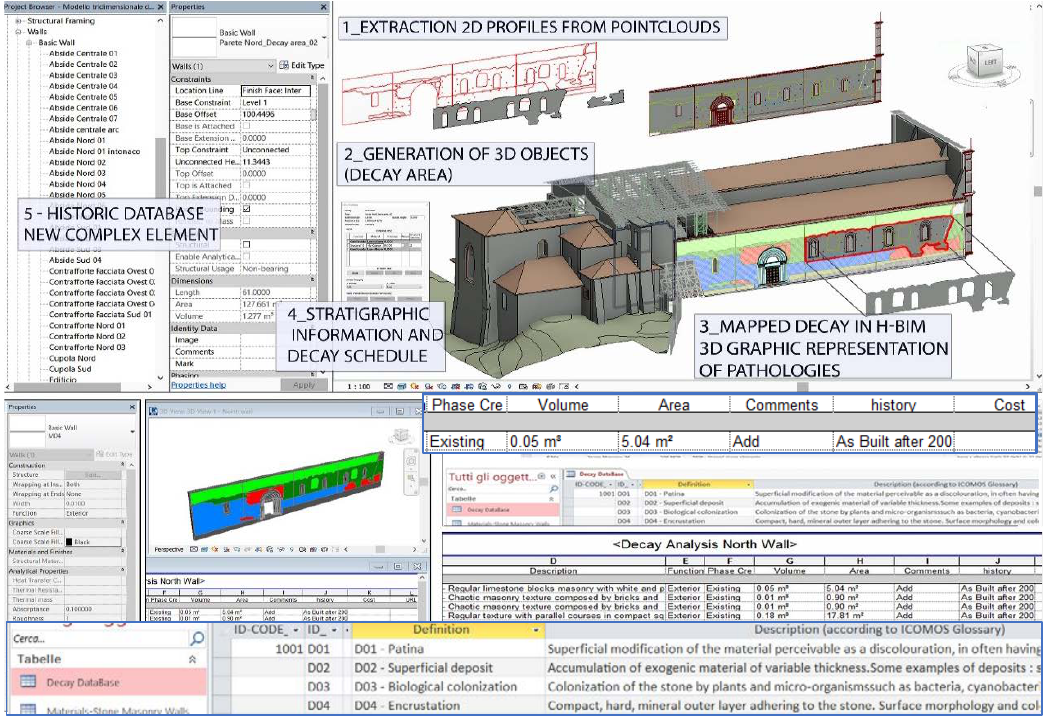
Figure 5. HBIM Material and Decay Mapping DB data management. From 2D to 3D HBIM NURBS model. Each material area is a parametric Object in the BIM DB with the 3D shape of the Objects (i.e. walls, vaults) belonging to the different